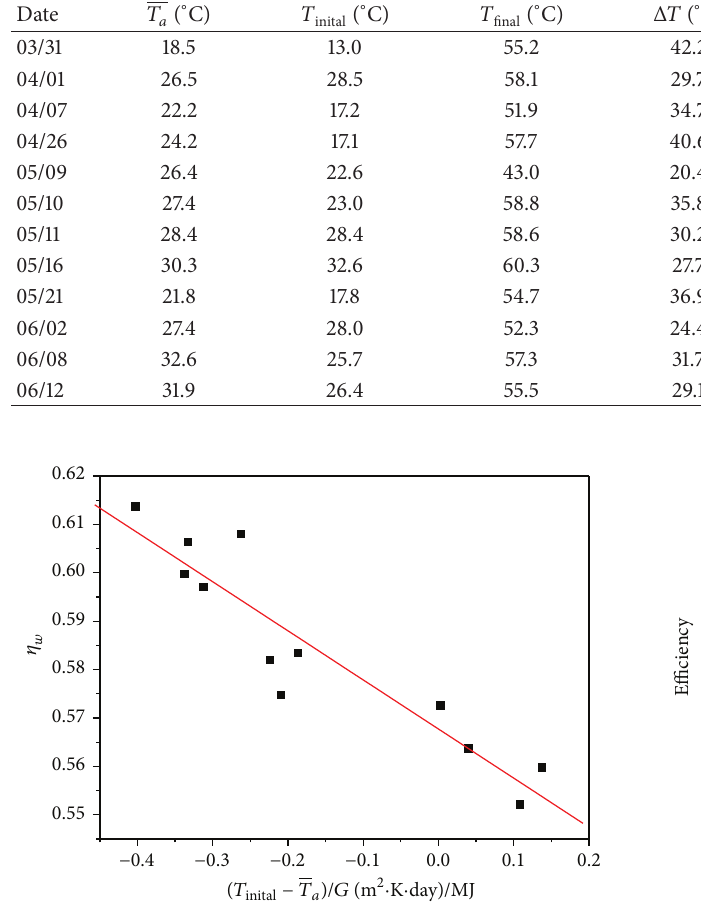
Figure 9: Graphical plot of test results of the water heating thermal efficiency.